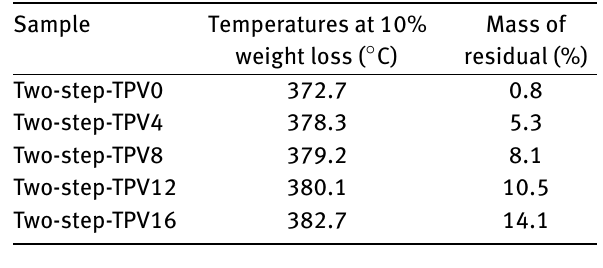
Table 1: TGA parameters for two-step-TPV with different content of CB.